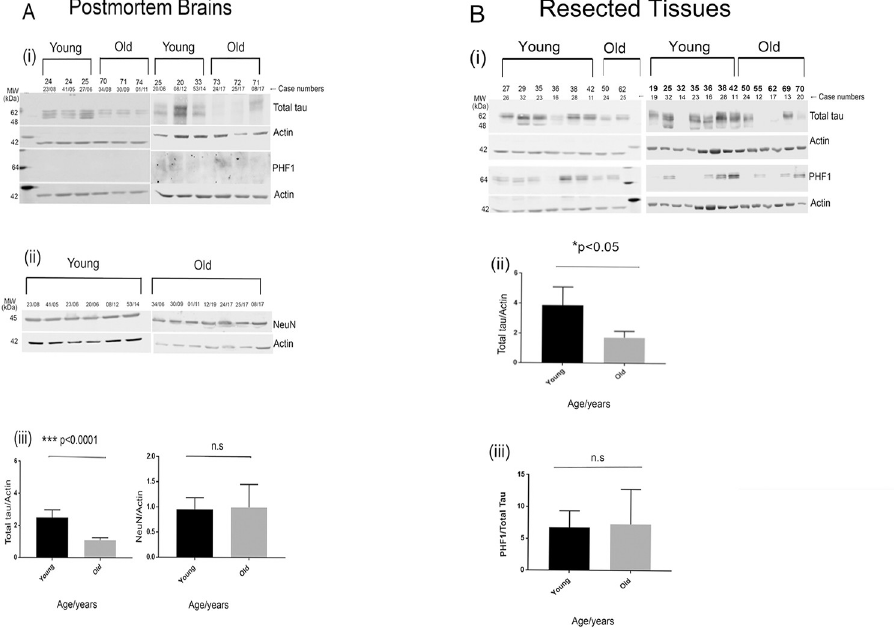
Fig 1. Total tau levels are significantly decreased in the healthy older brains compared to the younger brains. Representative western blot images for total tau, PHF1 and Actin in post-mortem brains (A i) and quantification of total tau normalized to Actin ( A iii). Representative western blot image for NeuN and Actin in post-mortem brains (A ii) and quantification of NeuN normalized to Actin (A iii). Representative western blot images for total tau, PHF1 and Actin in resected tissues (B i) and quantification of total tau normalized to Actin (B ii). Regression plot showing an increased trend of PHF1/Tau signal in the older cohorts compared to the younger group in resected tissue samples (B iii) In post-mortem samples n = 6 (older brains 70–74 years), n = 6 (younger brains 20–33 years), in resected tissue samples n = 13 (older brains 50–70 years and younger brains 19–42 years). ��� p < 0.0001, � p < 0.05 by two-tailed unpaired t test. Data represent mean ± SEM (A iii and B ii). An increased level of PHF1 immunoreactivity was observed in older brains of resected tissues although it was not significant (B